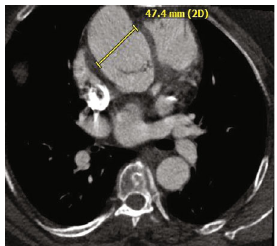
Figure 3: 3-dimensional reconstructed view of the sinus of Valsalva aneurysm and tortuous aortic